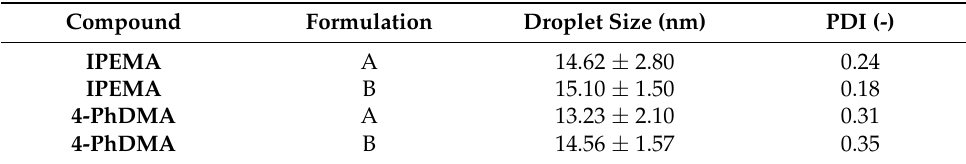
Table 5. Properties of the SEDDS developed for IPEMA and 4-PhDMA . Compound